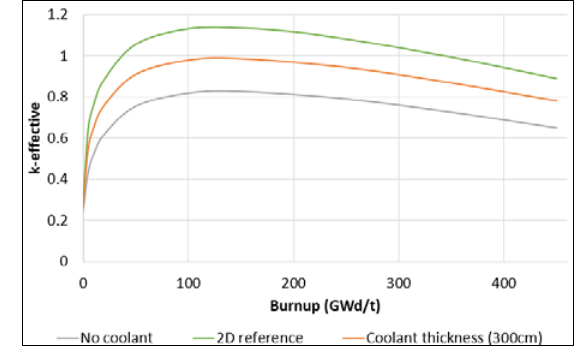
Figure 12. k eff_max versus burnup (coolant thickness). Figure 13. Reactivity-burnup (300cm coolant).